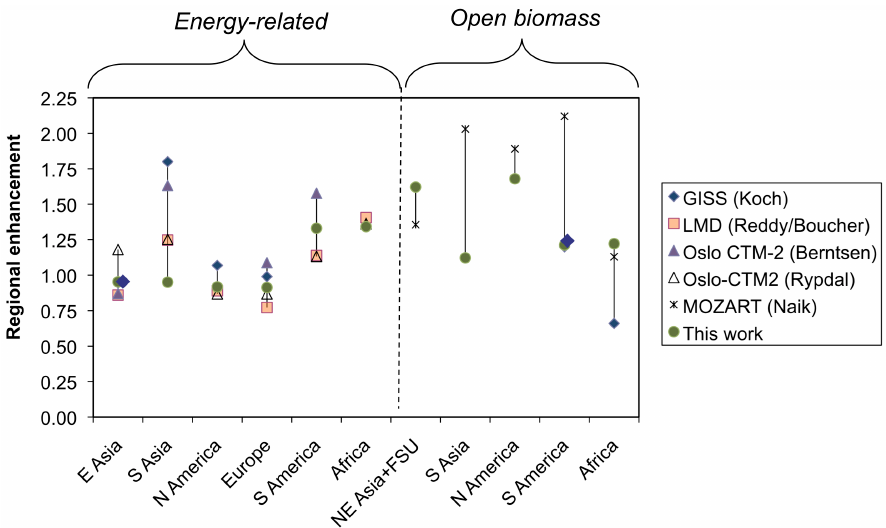
Fig. 8. Regional enhancement values for SFP dir from four models. Regional enhancement is the ratio between regional SFP and global average energy-related SFP. Oslo CTM-2 did not provide global average values, so East Asia is used as a normalizing region, because SFP for that region is close to the global average in other models.